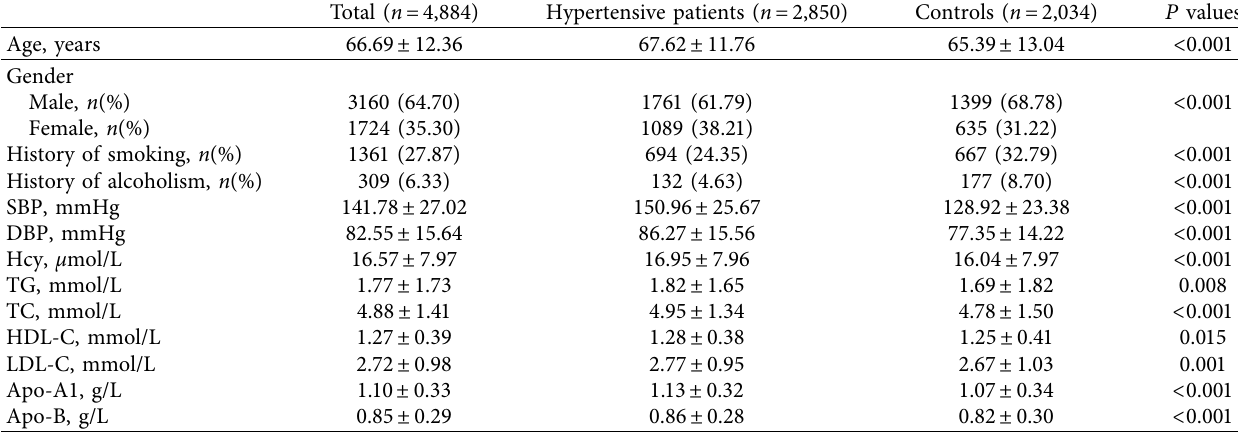
Table 1: Clinical characteristics of hypertensive patients and control participants.